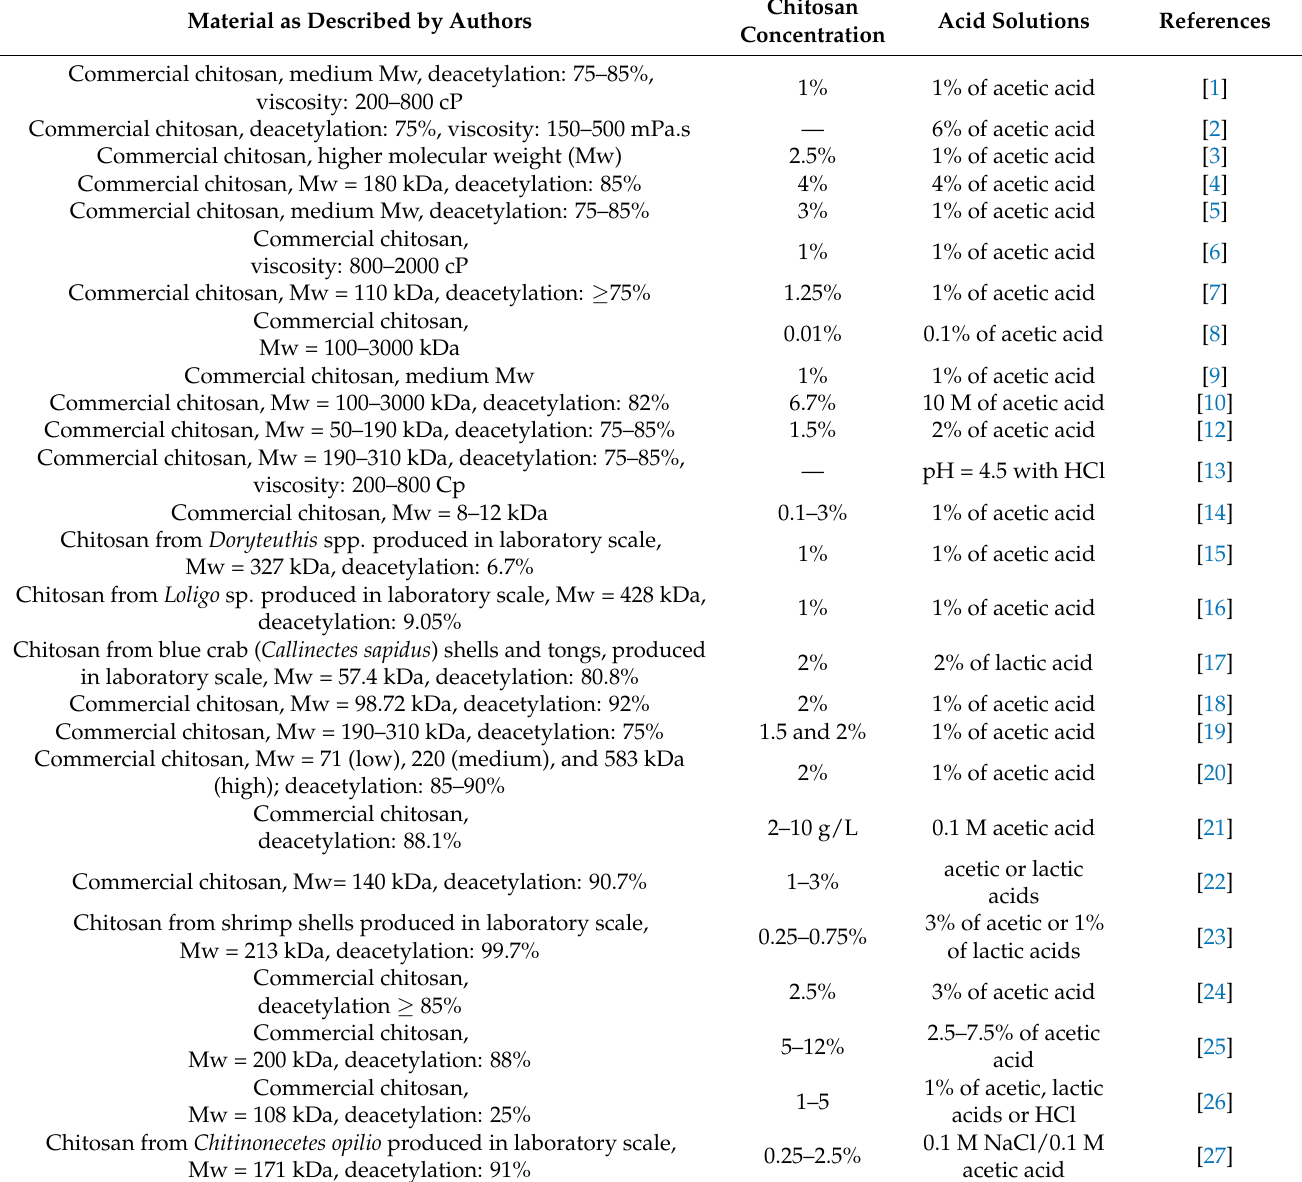
Table 1. Examples of different preparation conditions for chitosan and film-forming solutions.